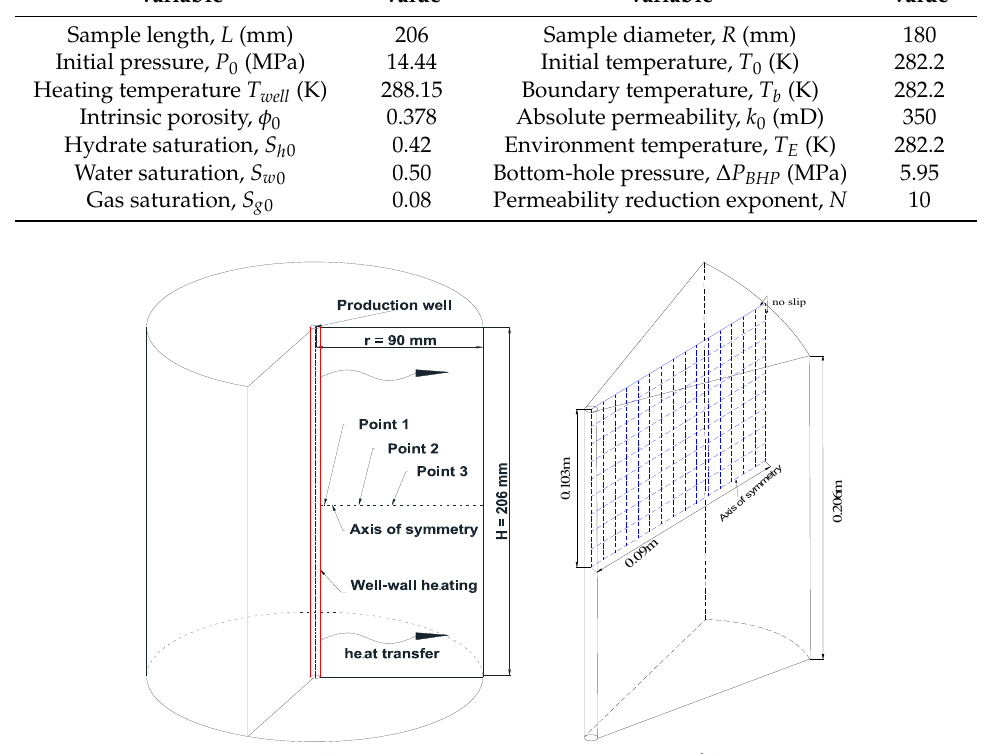
Table 1. Properties of hydrate bearing sample from Falser et al. [17].